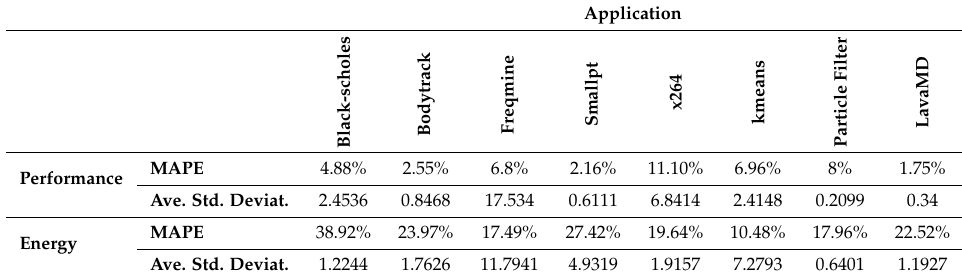
Table 5. The average standard deviation and mean absolute percentage error of performance and energy consumption of the estimated Pareto frontier against measured